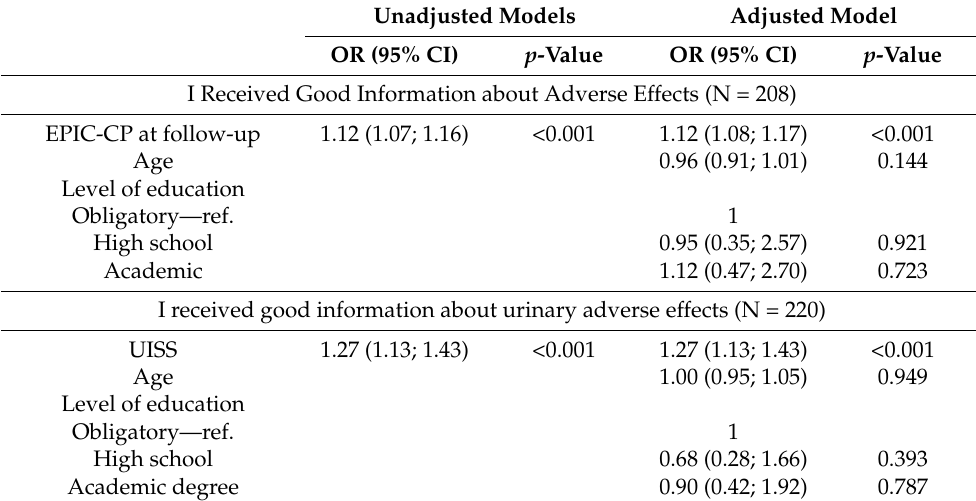
Table 3. Results of logistic regression analysis with dichotomized PREM items as